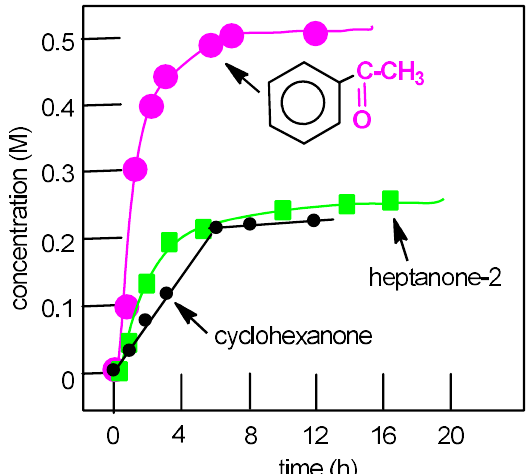
Figure 8. Accumulation of cyclohexanone, heptanone-2, and acetophenone in the oxidation of cyclohexanol (0.46 M), heptanol-2 (0.42 M), or 1-phenylethanol (0.5 M), respectively, with tert -butyl hydroperoxide (1.5 M) catalyzed by complex 1 (5 × 10 −4 M) in the absence of HNO 3 at 50 °C. In order to quench the oxidation process, concentrations of products were measured by GC only after the reduction of the reaction sample with solid PPh 3 .